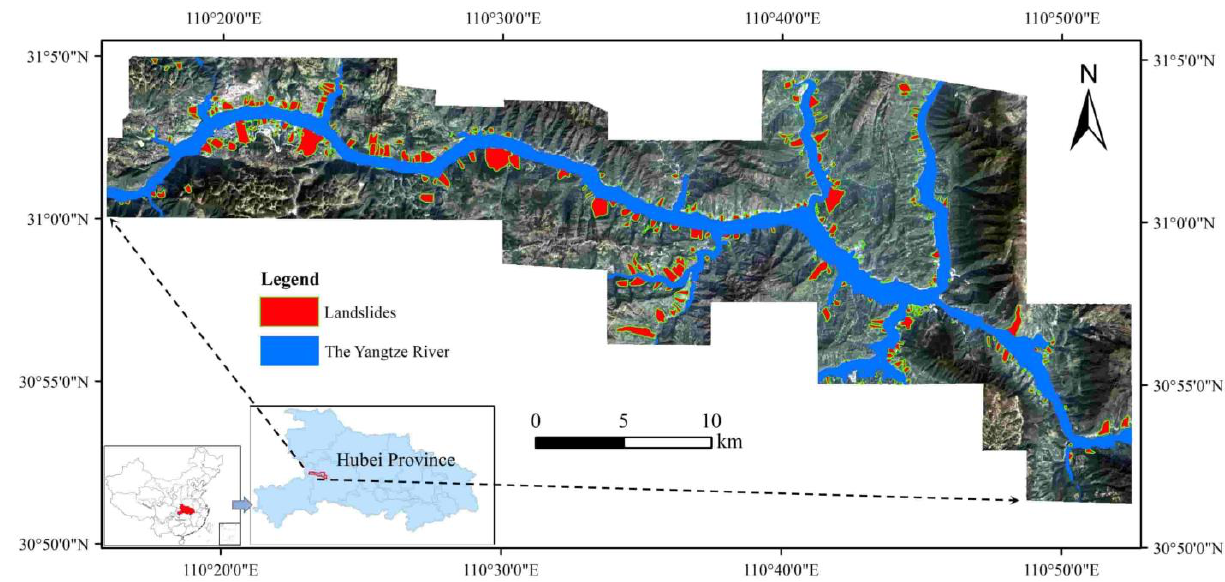
Figure 1. Location of the study area and the landslides ’ distribution.